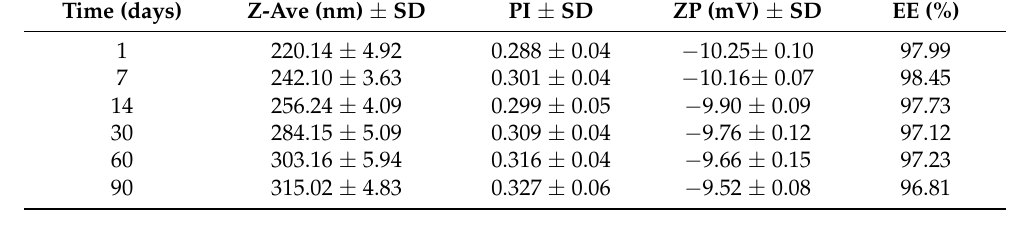
Table 9. Physicochemical stability of PF-NLCs-N6 at 4 ◦ C ( n = 3), monitored by the evaluation of any change in the following parameters: mean particle size, polydispersity index, zeta potential and encapsulation efficiency.